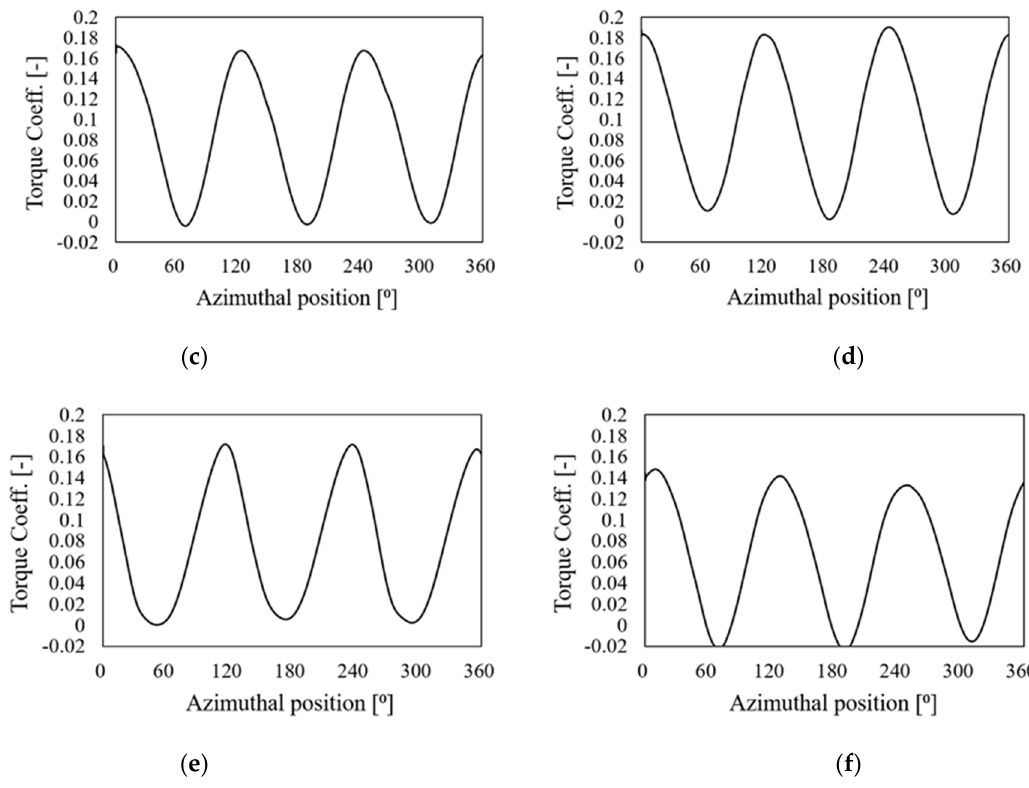
Figure 11. Torque coefficient for one turbine rotor rotation: ( a ) TSR = 1, ( b ) TSR = 2, ( c ) TSR = 3, ( d ) TSR = 3.5, ( e ) TSR = 4, ( f ) TSR = 5.